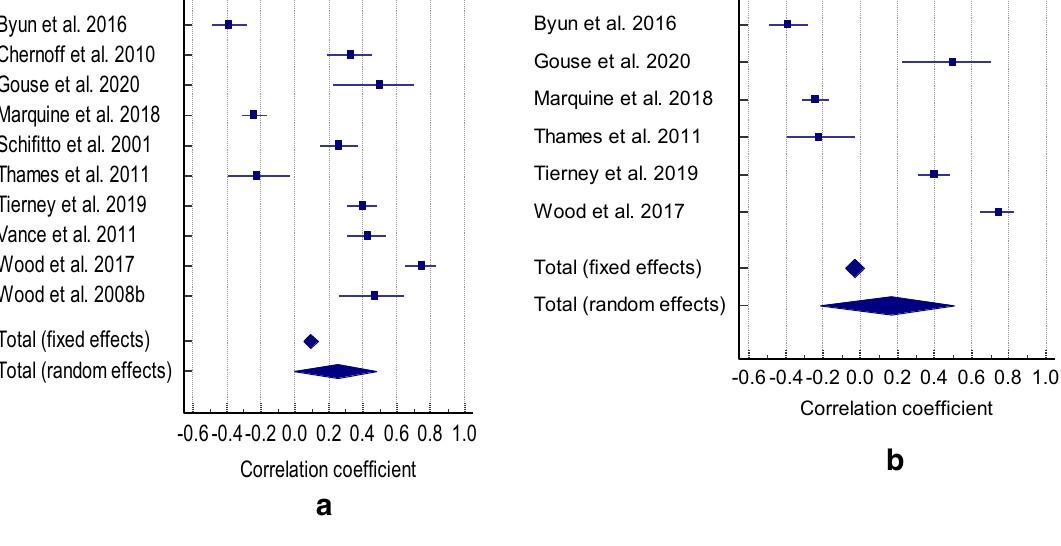
Figure 3. ( a ) Correlation between cognitive impairment and ADL ( b ) Correlation between cognitive impairment and ADL.